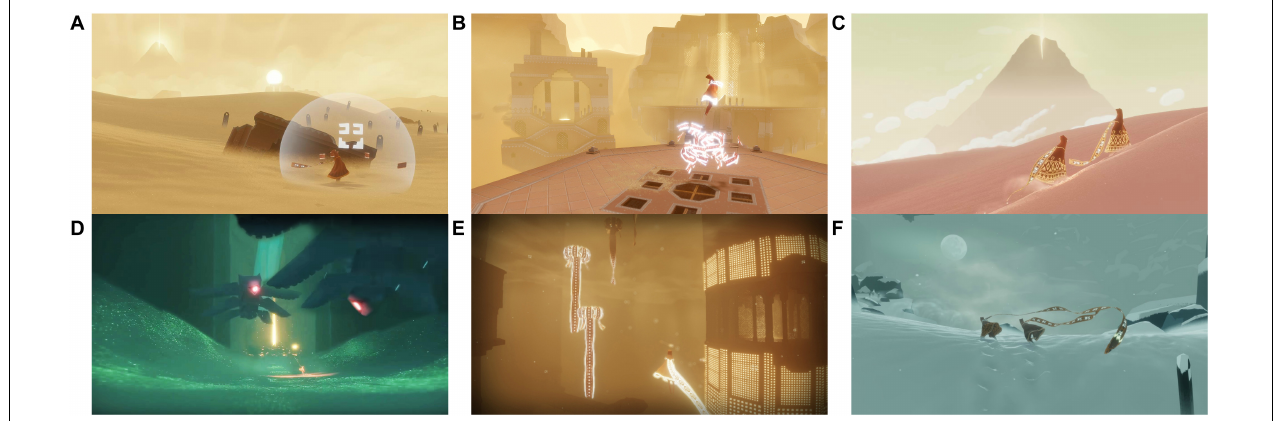
FIGURE 1 | Gameplay in Journey. Players travel through the desert (A–C) and underground areas (D,E) to the top of a snowy mountain (F) . Players communicate with a single tone (A) and can fly if energized by cloth (B) or other players (C) . These images are reproduced from Journey by Thatgamecompany (2012b) with the permission of the copyright holder Sony Interactive